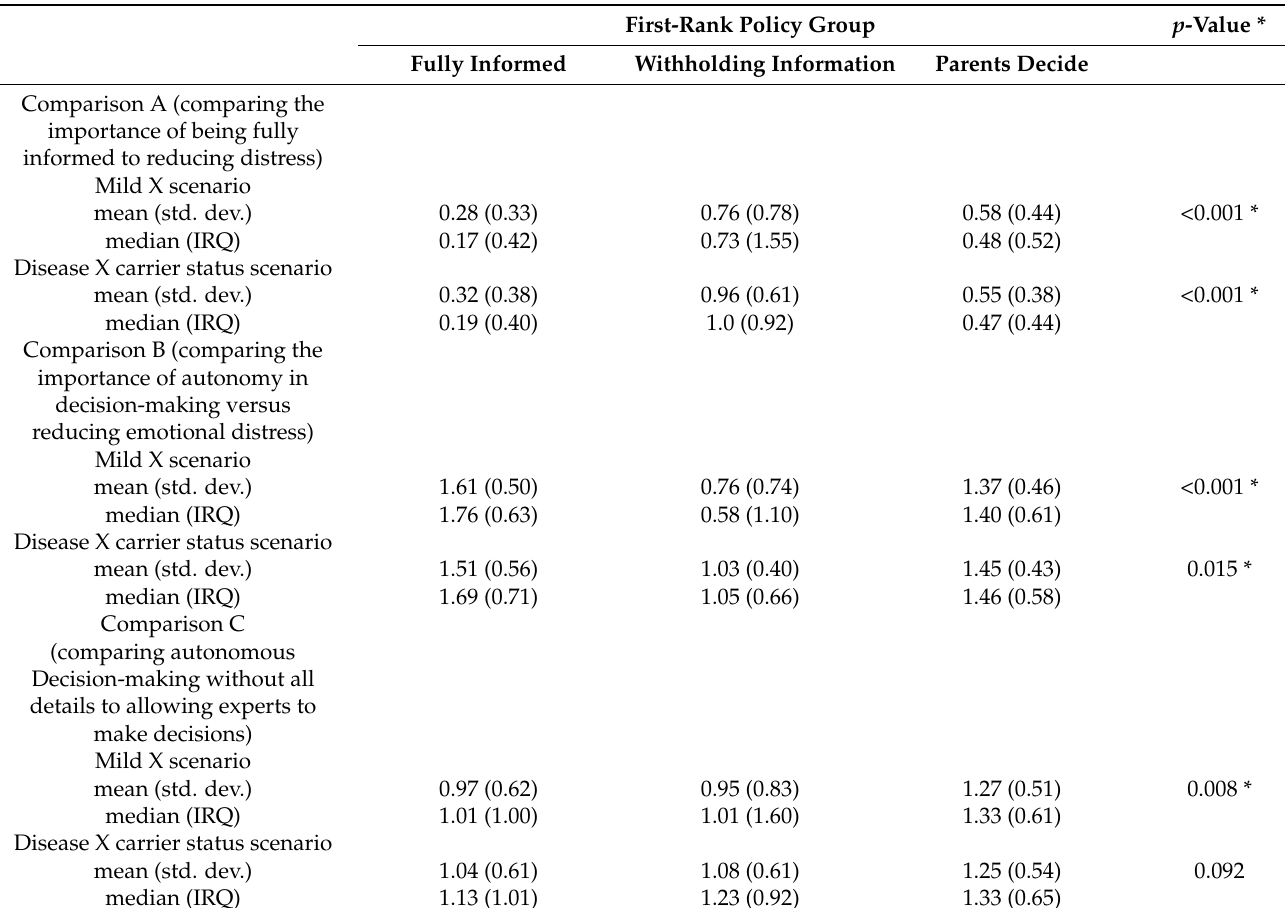
Table 3. Value Score Results for First-rank Policy